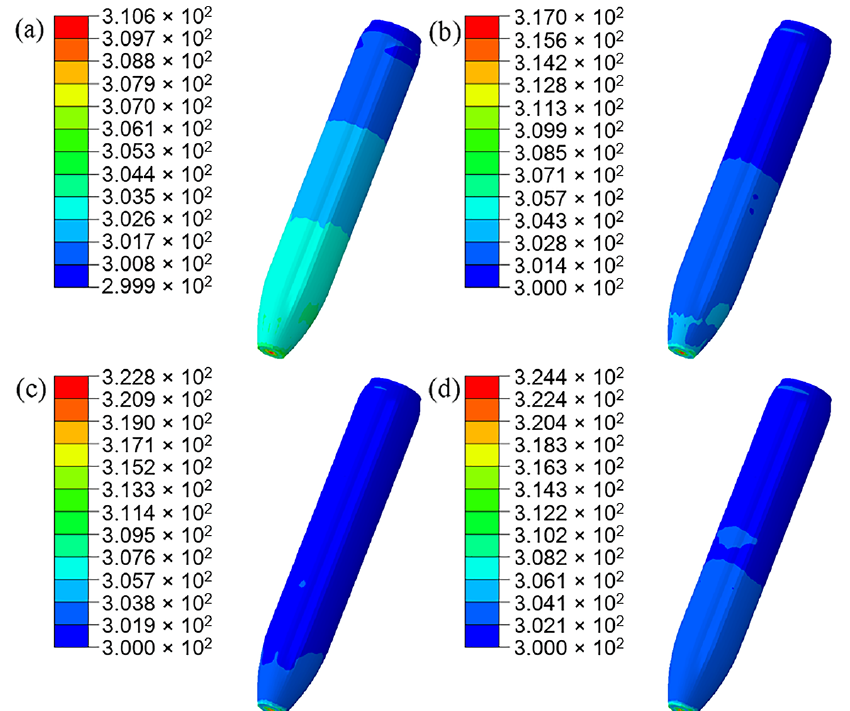
Figure 23. The evolution of the microcrack surface temperature on the lateral surface the PBX1314. ( a ) 800 µ s, ( b ) 1600 µ s, ( c ) 2400 µ s, ( d ) 3300 µ